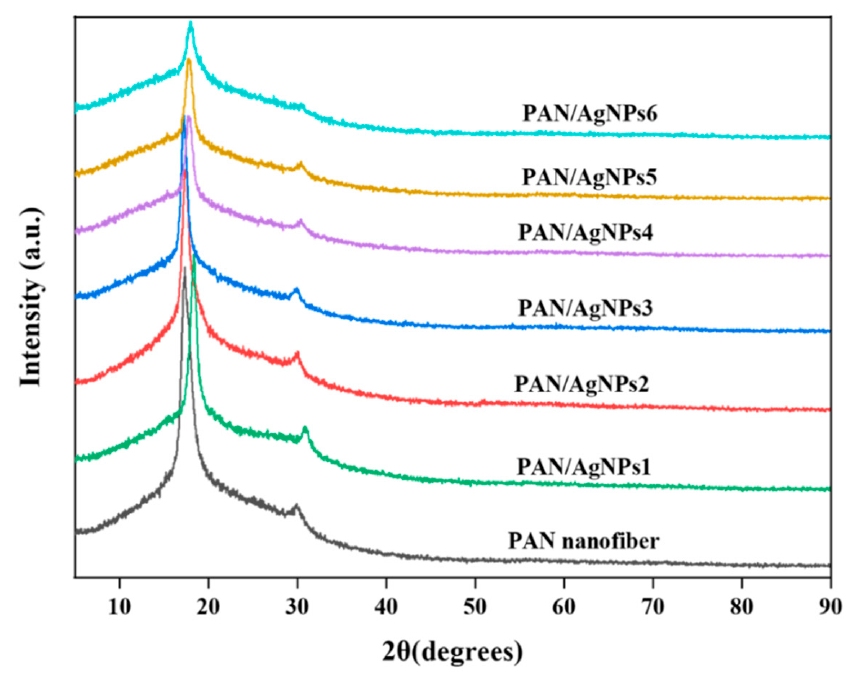
Figure 4. X-ray diffraction (XRD) spectra of PAN nanofiber, PAN/AgNPs1, PAN/AgNPs2, PAN/AgNPs3, PAN/AgNPs4, PAN/AgNPs5, and PAN/AgNPs6.